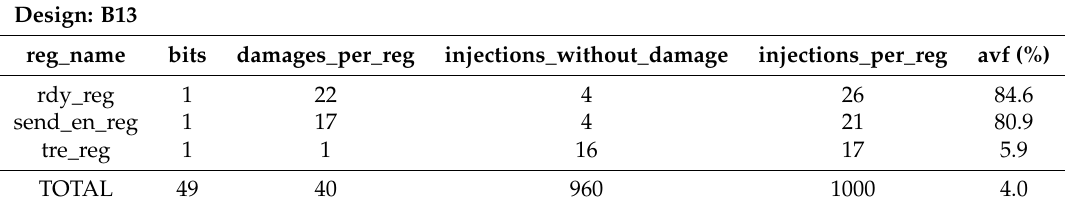
Table 4. Campaign for B13 design.